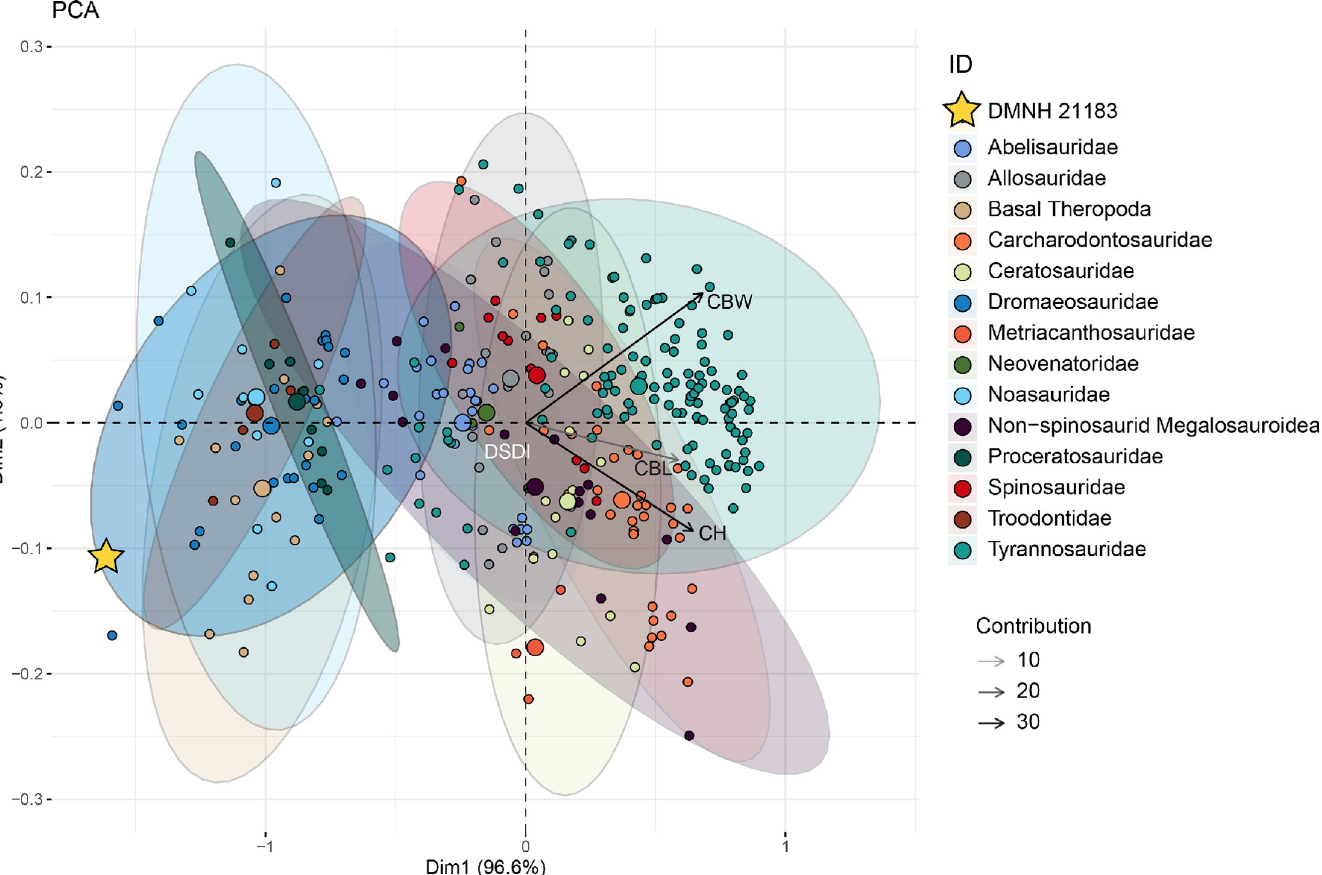
Fig 7. Position of DMNH 21183 in the theropod teeth morphospace. Principal components analysis of theropod teeth morphospace based on the dataset from Gerke and Wings [39]. DMNH 21183 is marked by a yellow star. Abbreviations: crown height (CH), crown basal width (CBW), ratio between mesial (anterior) and distal (posterior) denticles (DSDI). Morphometric dataset prepared as explained in methods and including measurements from DMNH 21183 reported in Supplementary Information (S2 Dataset). https://doi.org/10.1371/journal.pone.0235078.g007 combination of ziphodont dentition, presence of interdental plates (e.g. [75]), a Meckelian groove, and Meckelian foramina are characteristic of theropod dinosaurs (e.g. [76]). The ori- entation of the anterior-most tooth socket and its unerupted tooth (both anteromedially ori- ented), the presence of paired Meckelian foramina, and a ventral expansion laterally pierced by a fossa, point toward the identification of the specimen as an anterior portion (almost sym- physeal, as also shown by the ventral enlargement of the dentary in lateral view) of a theropod dentary. The shallow Meckelian groove present in the specimen is a derived maniraptoran fea- ture [77], in contrast to the deep groove seen in basal tyrannoraptorans (e.g.